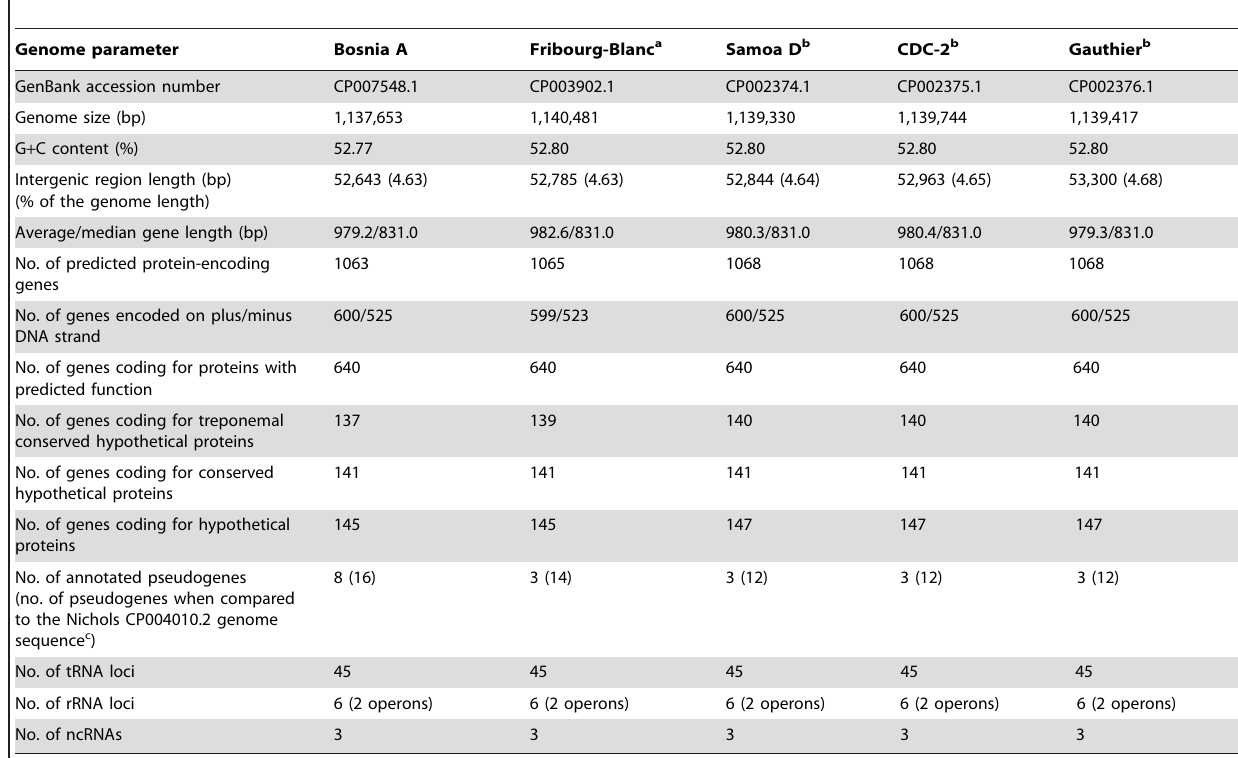
Table 1. Summary of the genomic features of the Treponema pallidum subsp. endemicum Bosnia A strain and four T. pallidum subsp. pertenue strains (Samoa D, CDC-2, Gauthier and Fribourg-Blanc).